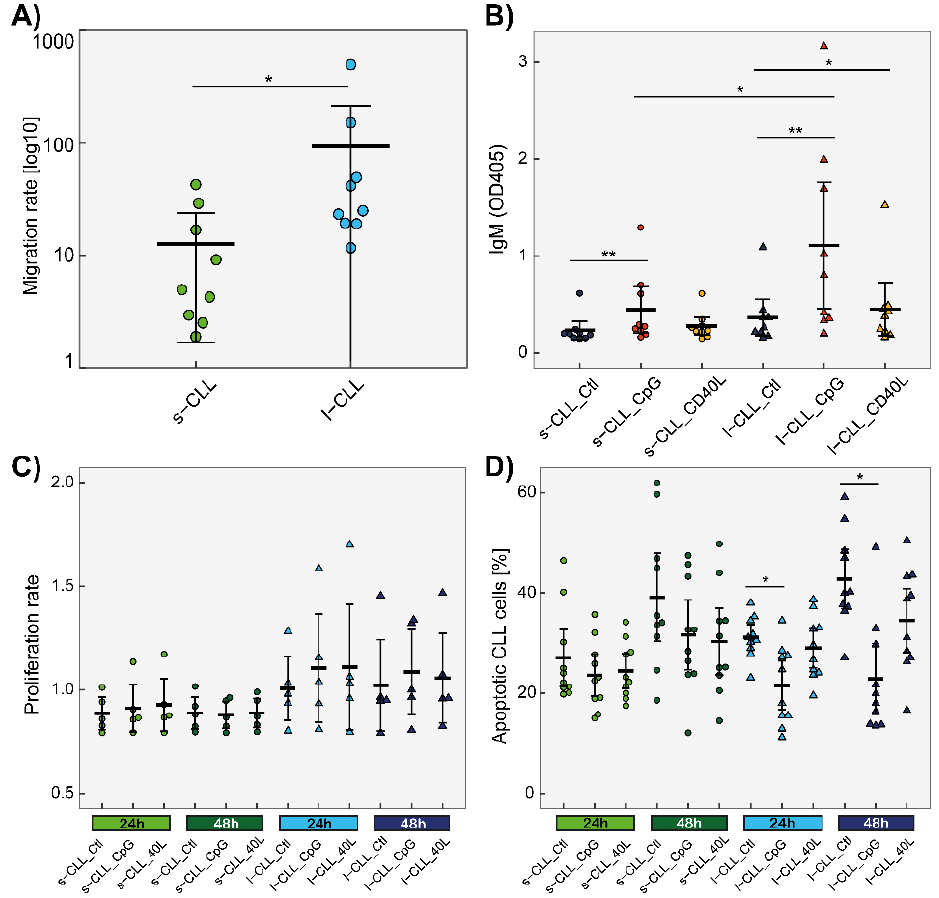
Figure 6. The functional differences between s-CLL and l-CLL cells. ( A ) The migration rate of the sorted s-CLL and l-CLL cells ( n = 9). The migration rate was calculated as the ratio of CXCL12-treated cells to untreated cells that transmigrated through the insert. y-axis is displayed in logarithmic scale. ( B ) The IgM production in the supernatants of cultured s-CLL and l-CLL cells ( n = 8); 1 × 10 6 sorted cells were cultured in the absence or presence of CpG or CD40L for 48 h. The OD 405 values are plotted without subtracting the background, as determined by ELISA. ( C ) The cell viability (proliferation) of cultured CLL cells ( n = 9); 0.5 × 10 5 sorted cells ( n = 5) were cultured in the absence or presence of CpG and CD40L for 24 and 48 h. The proliferation rate was calculated as the ratio of OD 570 to OD 605 . ( D ) Apoptosis was measured with annexin V and PI ( n = 10). Annexin V-positive/PI-negative cells were considered apoptotic. * p < 0.05, ** p <